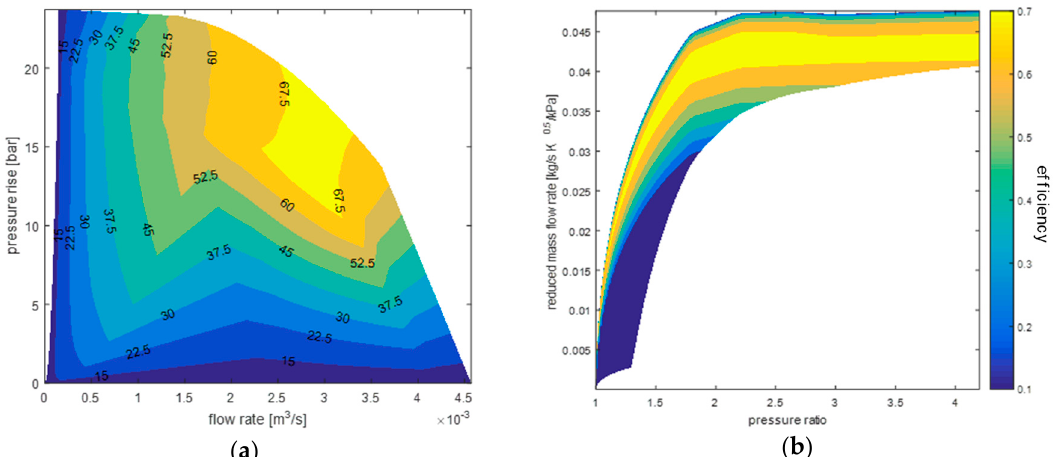
Figure 2. Performance maps used as inputs for models of dynamic machines: ( a ) efficiency map of a centrifugal pump for heat to power applications based on Organic Rankine Cycles (ORC); ( b ) Turbine total-static efficiency map of a radial ORC turbo-expander [16].